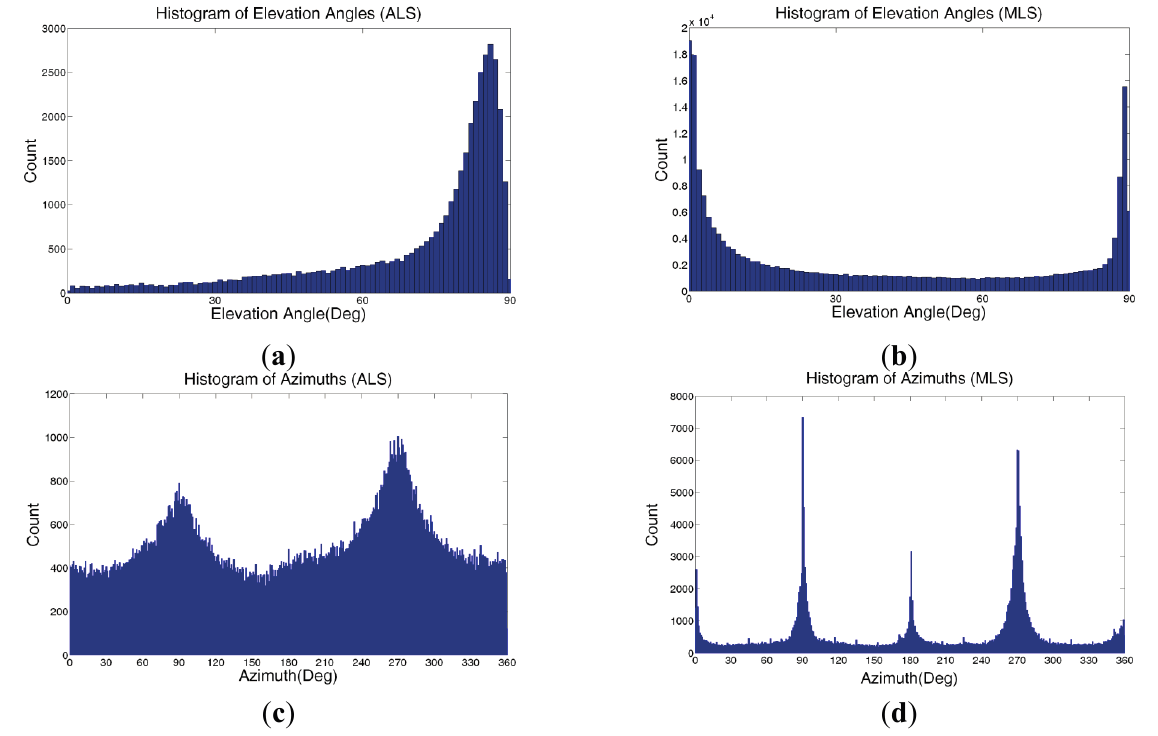
Figure 11. Histogram of elevation and azimuth angles: ( a ) elevation angles of